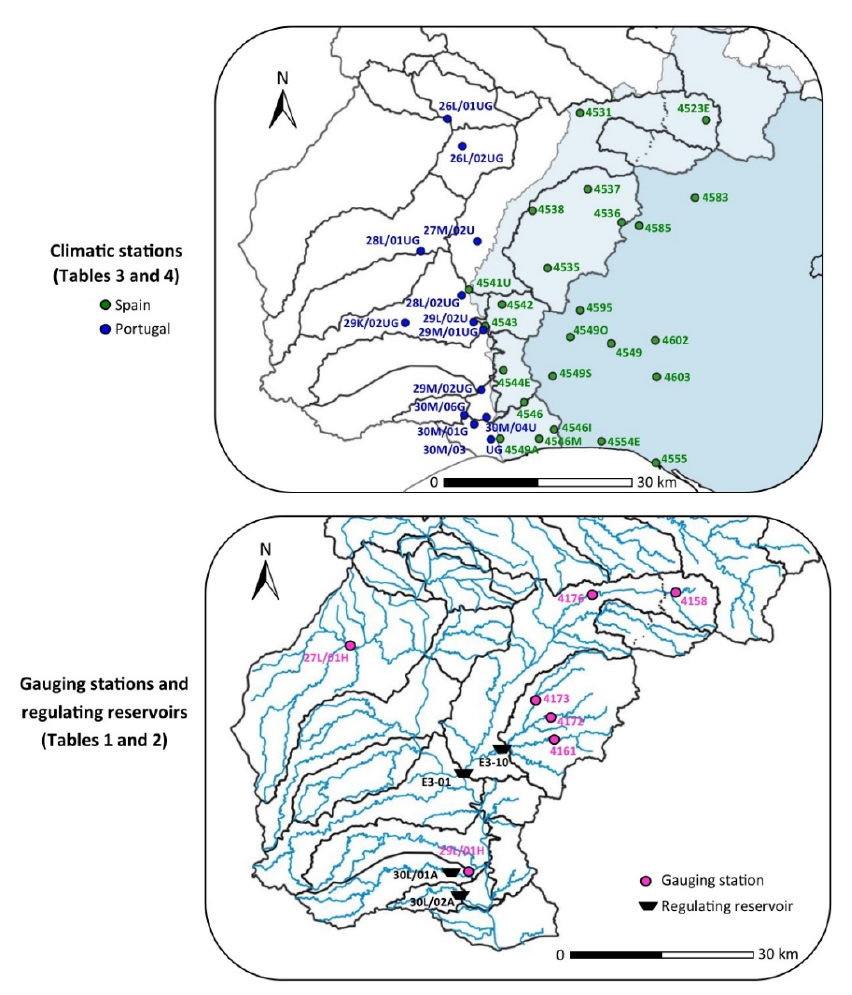
Figure 2. Climatic stations, gauging stations, and regulating reservoirs distributed along all the Lower Guadiana River Basin [17].